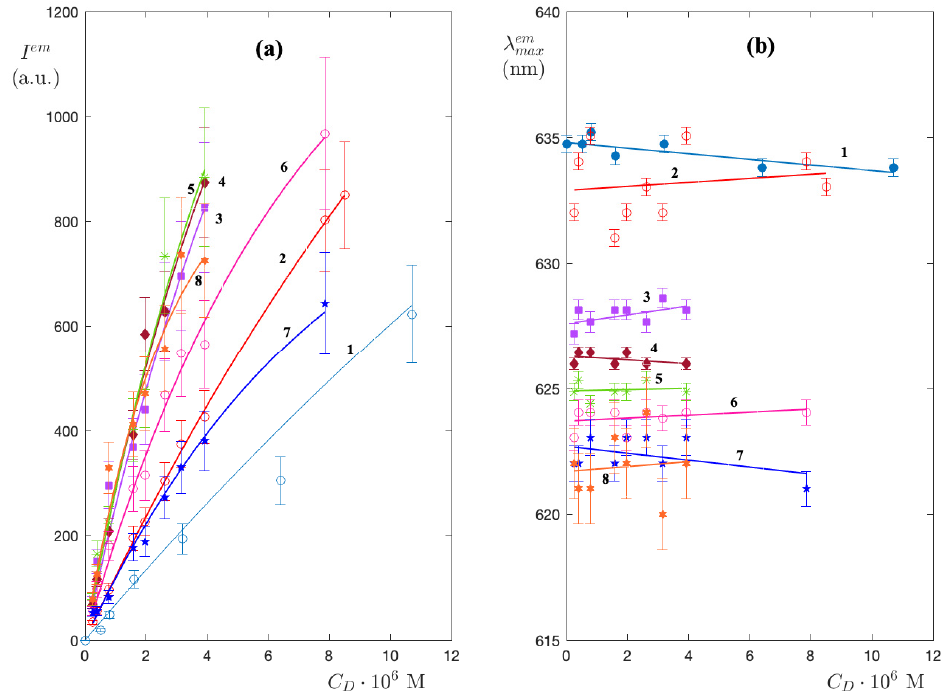
Figure 7. ( a ) Area under the emission band as a function of NR molar concentration. Although the concentration is low, the fluorescence exhibits a non-linear trend. ( b ) The wavelength of the maximum emission as a function of NR molar concentration.